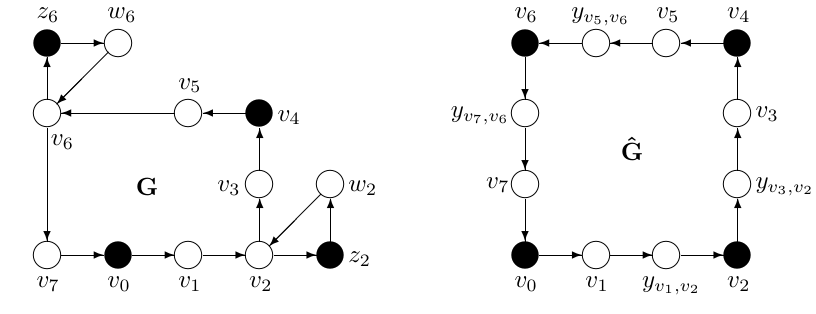
Fig. 9: An example for the construction of ˆ G from G